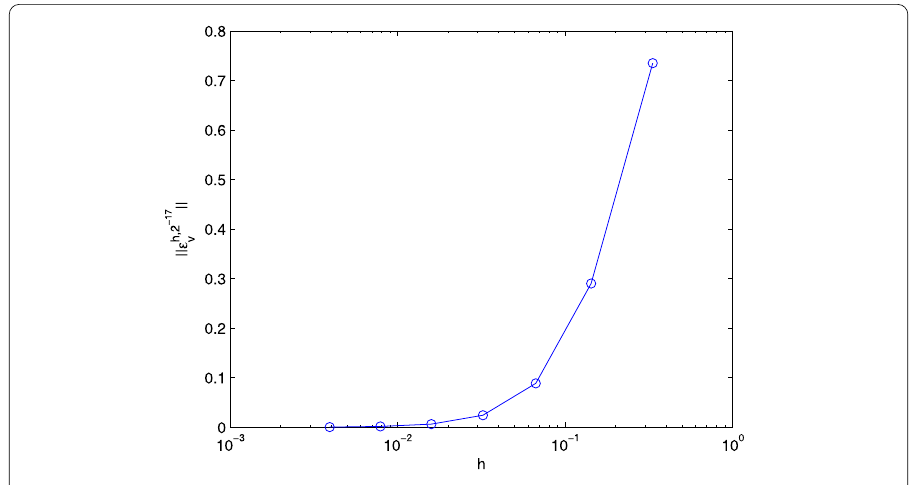
–17 (cid:7) for τ = 2 –17 , with respect to h of Example 1 v